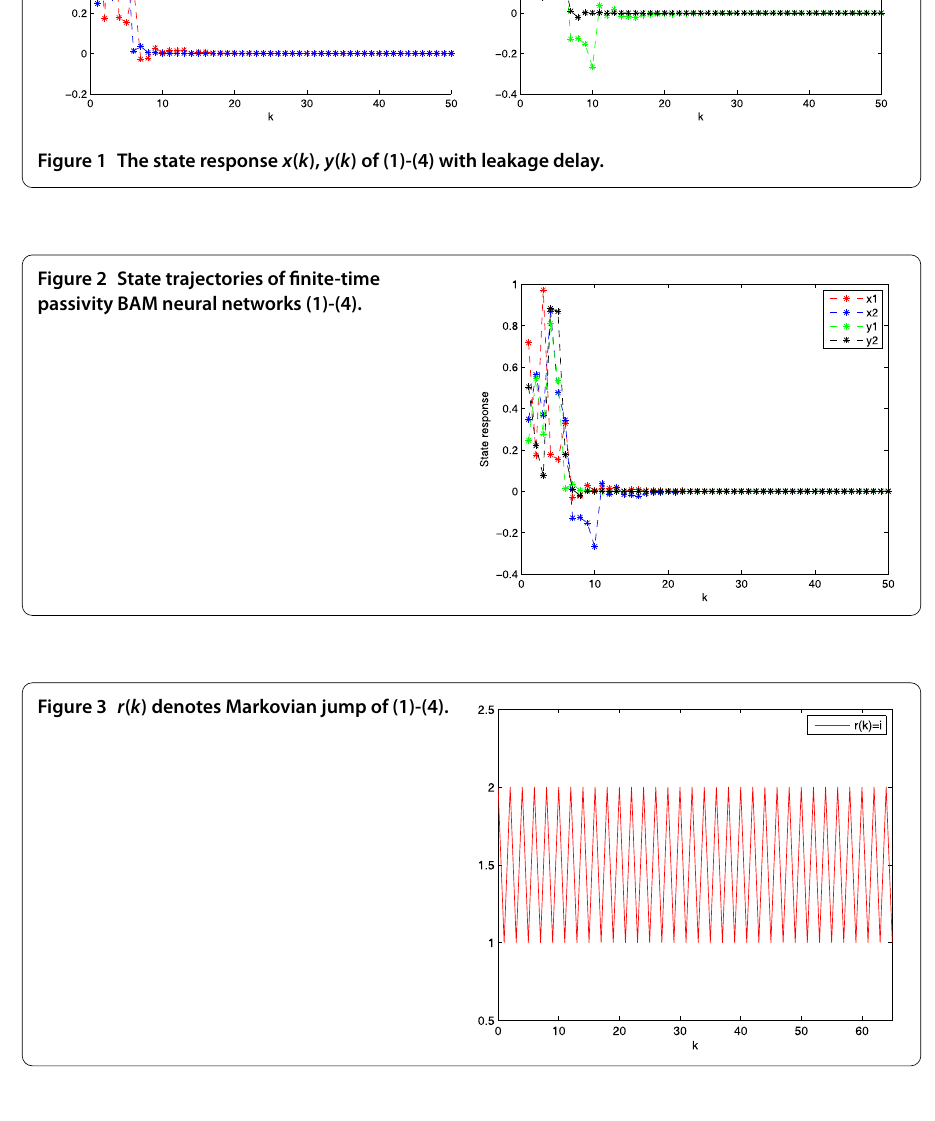
Table 1 Optimal values of χ for different τ M and σ M τ M : 12 14 16 18 20 22 σ M : 10 12 14 16 18 20 χ 5.3 8 10.6 12 13.89 15.04